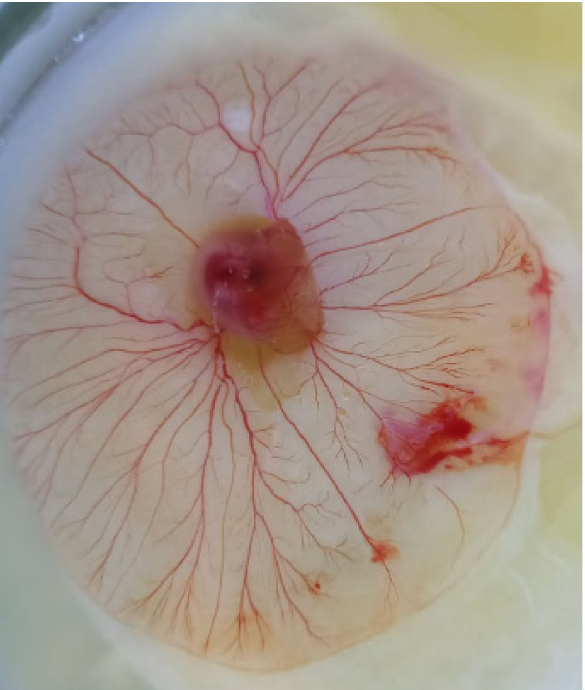
Figure 3. Development of the embryo of the Treh20 experimental group on the 7th day of